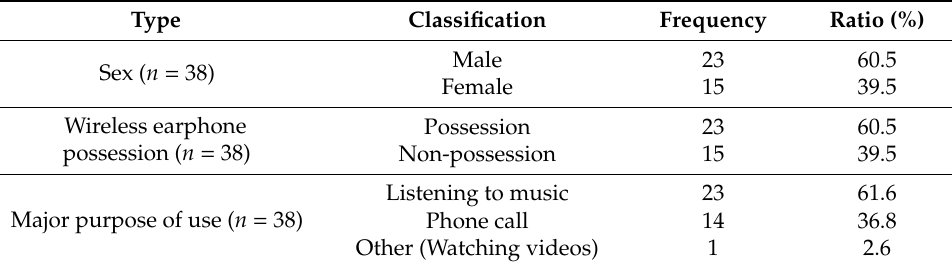
Table 6. Demographics II—participant classification by the status of earphone usage.